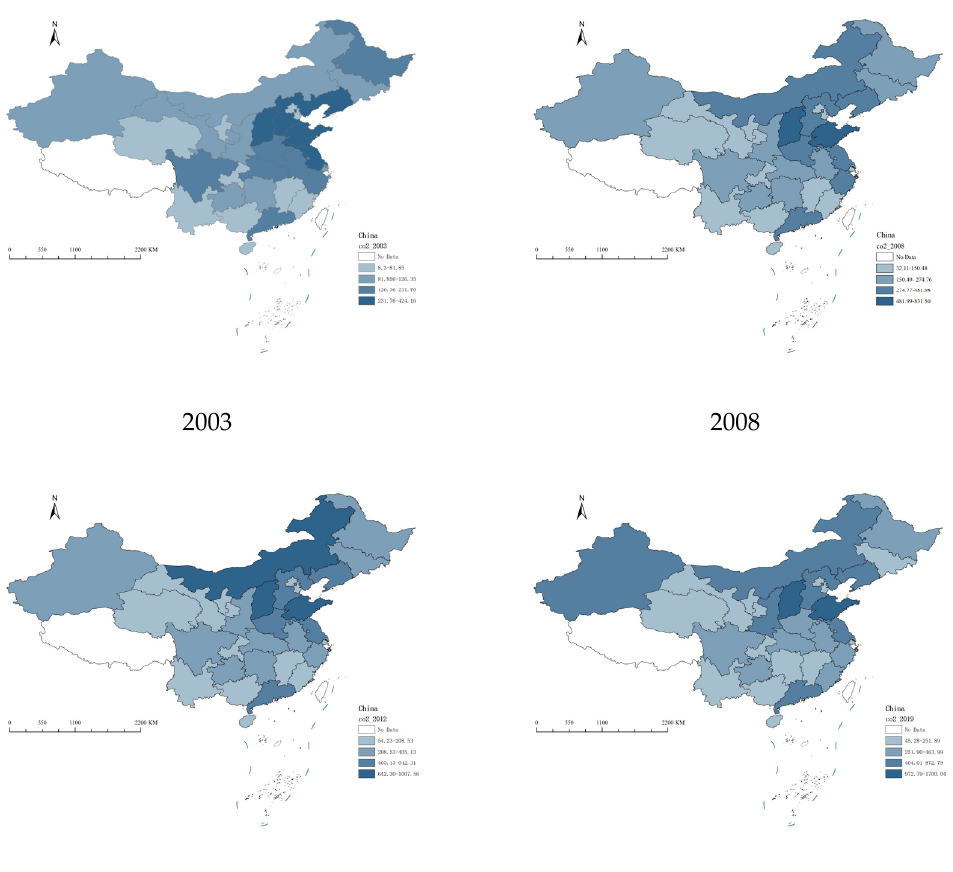
Figure 6. The level of carbon emissions in China.